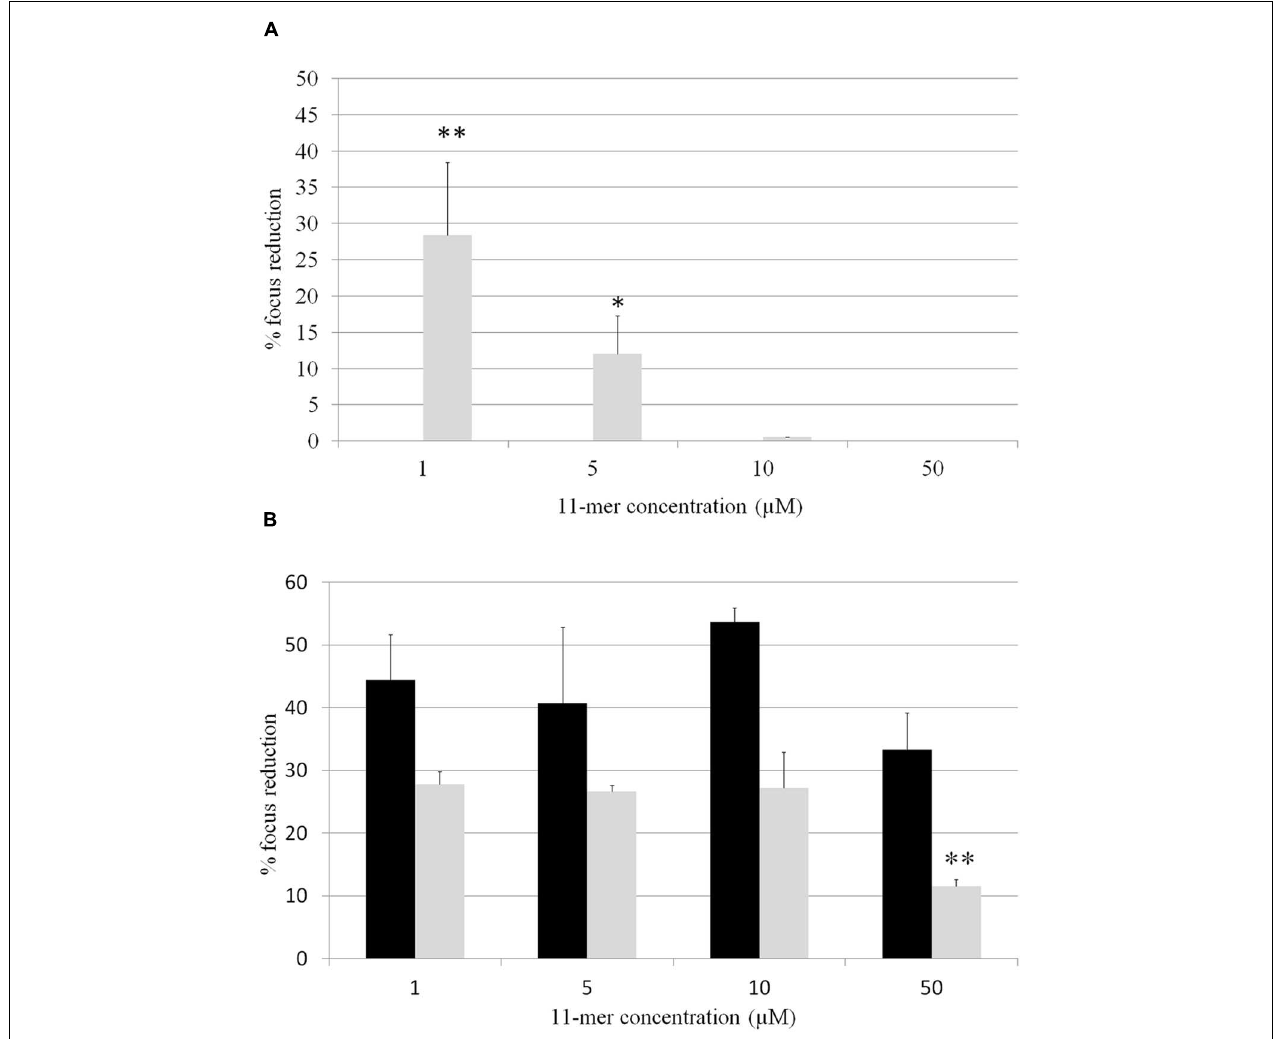
FIGURE 2 | Percentage of focus reduction in human rotavirus infection by strategy A, in which 11-mer peptide was incubated with rotavirus followed by the infection of the cells with this virus-compound mixture. Black bars correspond to MA-104 cell line and gray bars to HT-29 cell line. (A) Wa virus assays; (B) Ito virus assays. No inhibition was obtained for virus Va70. Data are the average of at least two independent experiments. Error bars represent the standard errors for replicates. ∗ P -value < 0.05; ∗∗ P -value <